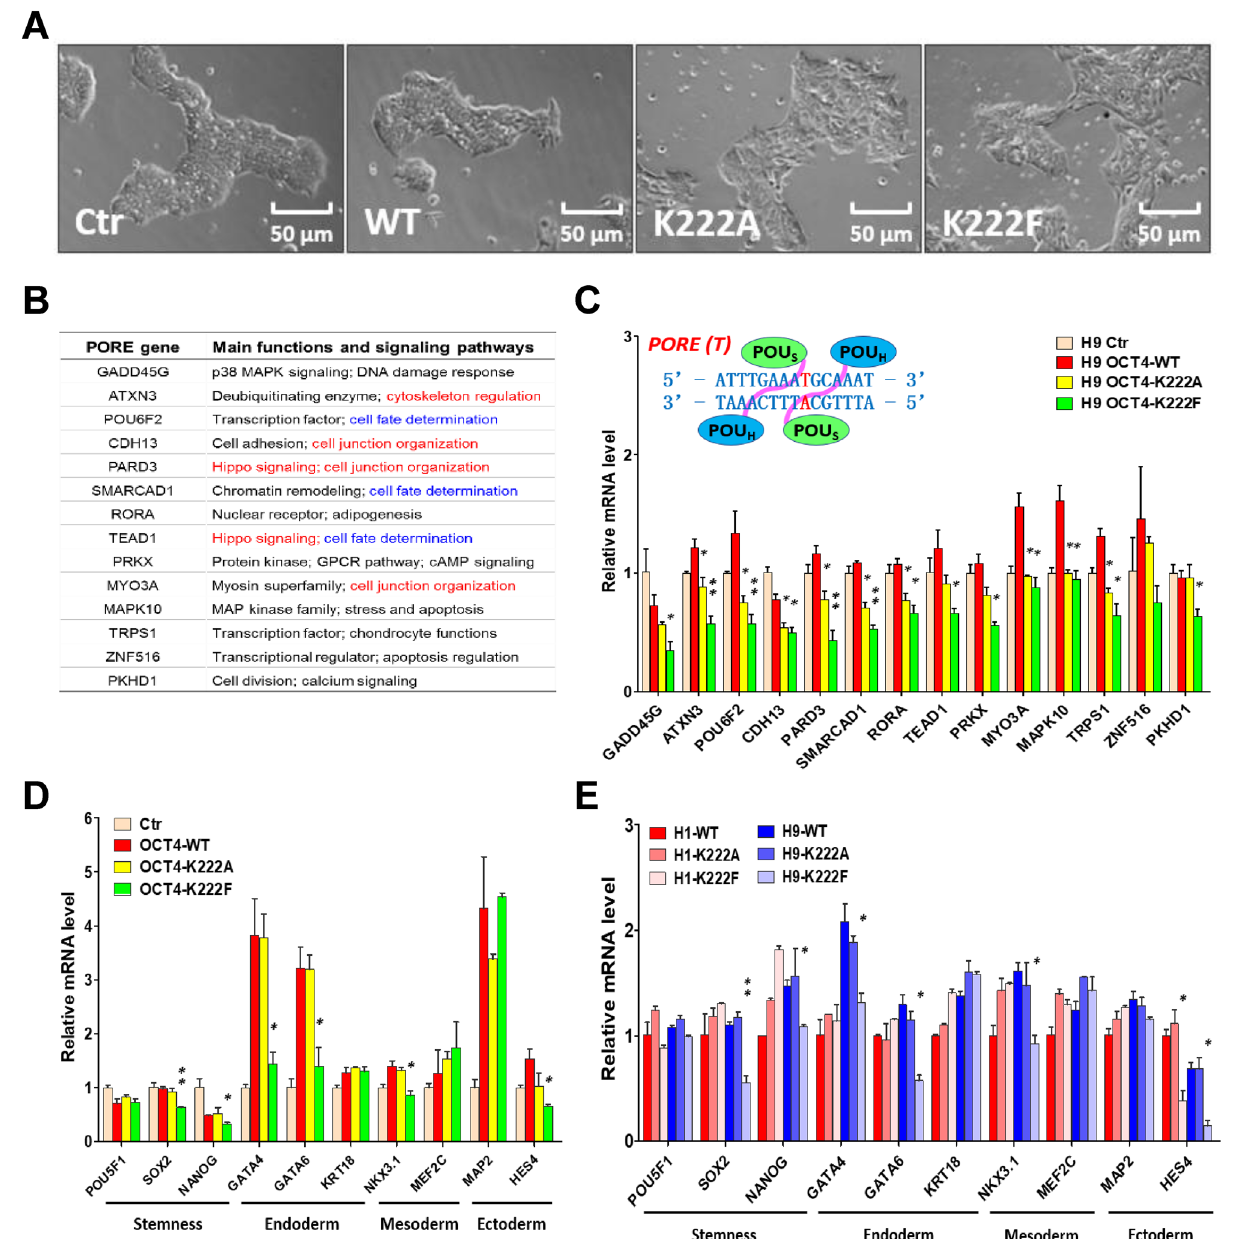
Figure 5. OCT4-K222 methylation represses the transcription of PORE-motif-containing target genes in vivo and the differentiation capacity of PSCs. ( A ) The morphology of H9 cells 72 h after transfection with shOCT4- FLAG-OCT4 (WT and variants) constructs. ( B ) A brief summary of PORE genes’ main functions. ( C ) H9 cells were transfected with shOCT4-FLAG-OCT4 (WT and variants) constructs with the empty vector as a control. 72 h later, cells were harvested and the relative mRNA levels of the PORE genes listed in ( B ) were determined by qRT-PCR. (D,E) The relative mRNA levels of the stemness genes and lineage-specific marker genes in H9 ( D ) and H1 ( E ) cells subjected to the same transfection procedures as in ( C ) were determined by qRT-PCR. Results shown in ( C ), ( D ) and ( E ) were presented as means ± S.D. of triplicate measurements from single experiment. Two-tailed unpaired Student’s t tests were used for statistical analyses. *P < 0.05 and **P < the differentiation of cultured PSCs into embryoid bodies and neural ectodermal cells. To track transcriptional changes of the PORE genes during RA-induced differentiation of ECCs, NCCIT cells were treated with RA for 0, 3, and 9 days, respectively. Most PORE genes showed time-dependent suppression in transcription (Figure S11), consistent with the assumption that transcription of the PORE genes is positively associated with the self- renewal and pluripotency of PSCs. We further investigated the effects of two LSD1 inhibitors, 2PCPA and OG-L002 which presumably increase the OCT4-K222 methylation, on RA-induced differentiation of NCCIT cells. NCCIT cells were pre-treated with